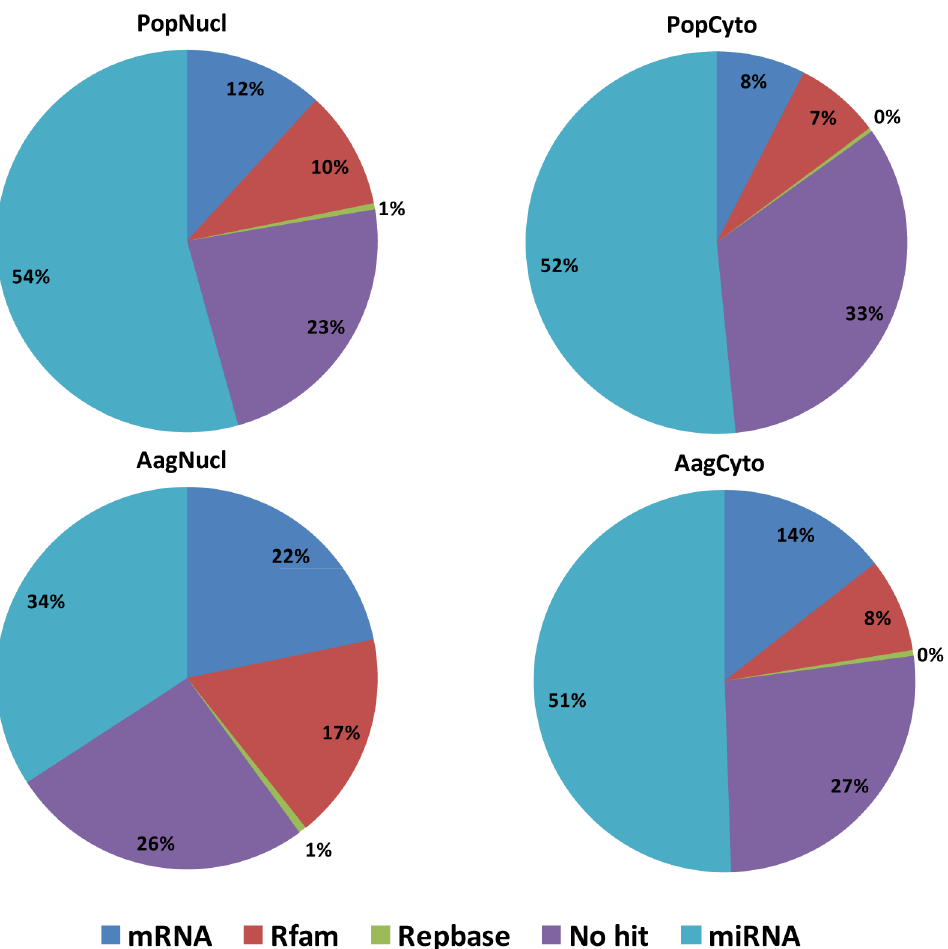
Figure 2. Small RNA deep sequencing reads statistics for the four libraries deep sequenced using RNA samples from the nucleus and the cytoplasm of Aag2 and Pop cells.